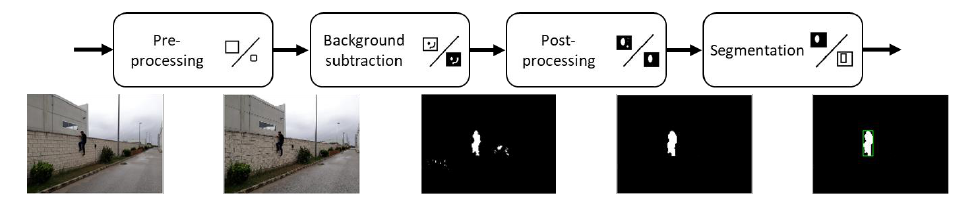
Figure 14. Image detection pipeline.